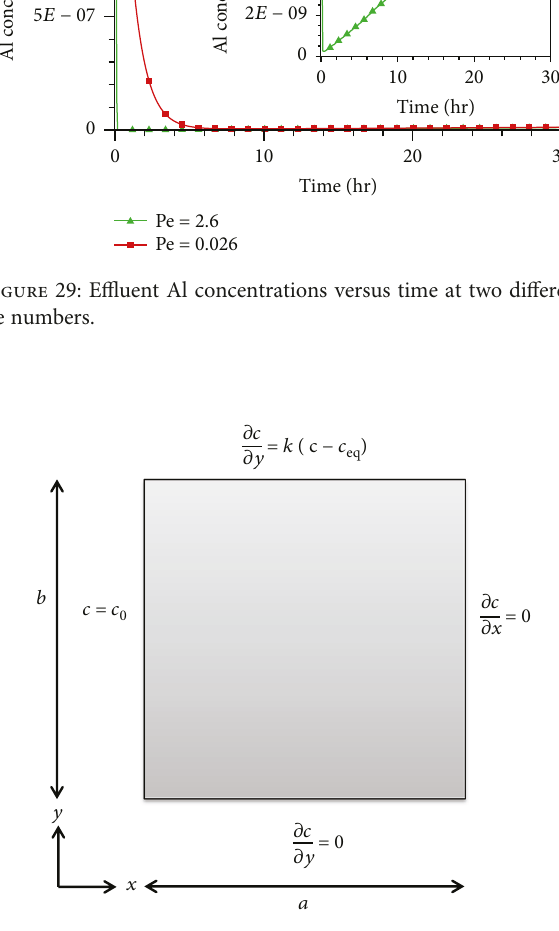
Figure 30: Schematic of the domain used for single-species reaction-di ff usion benchmark.